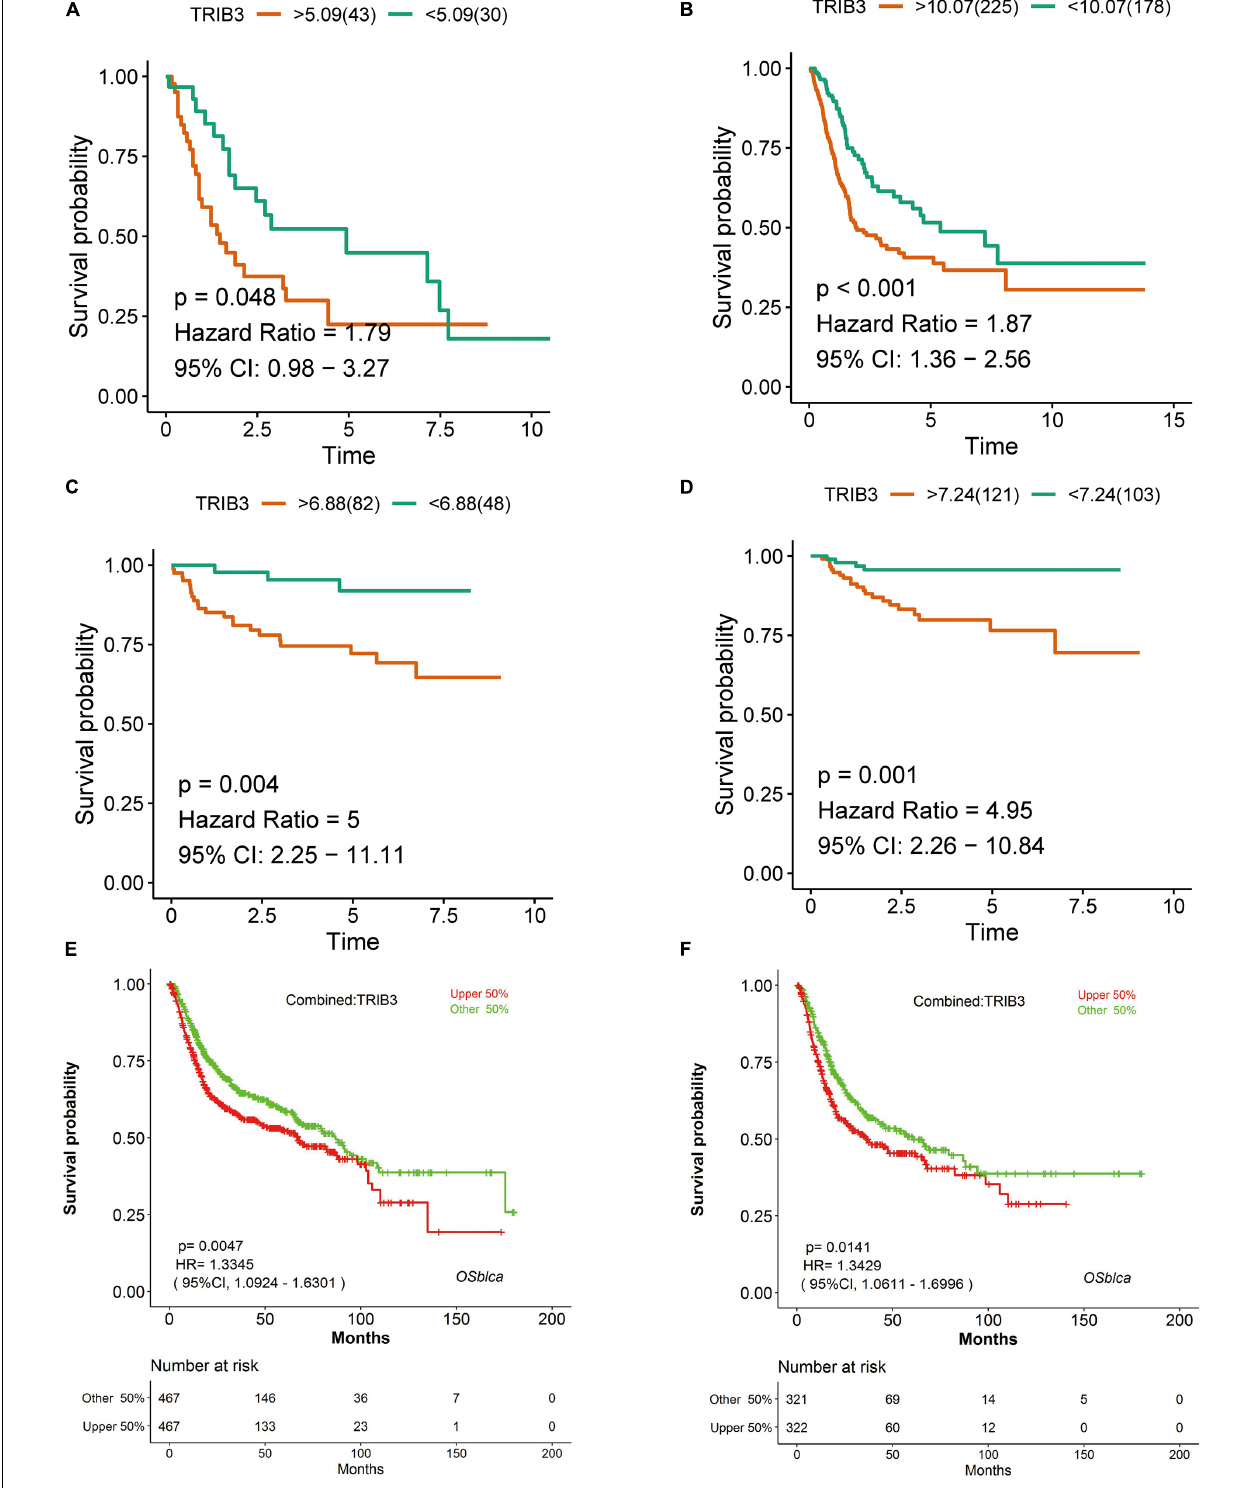
Frontiers in Genetics |